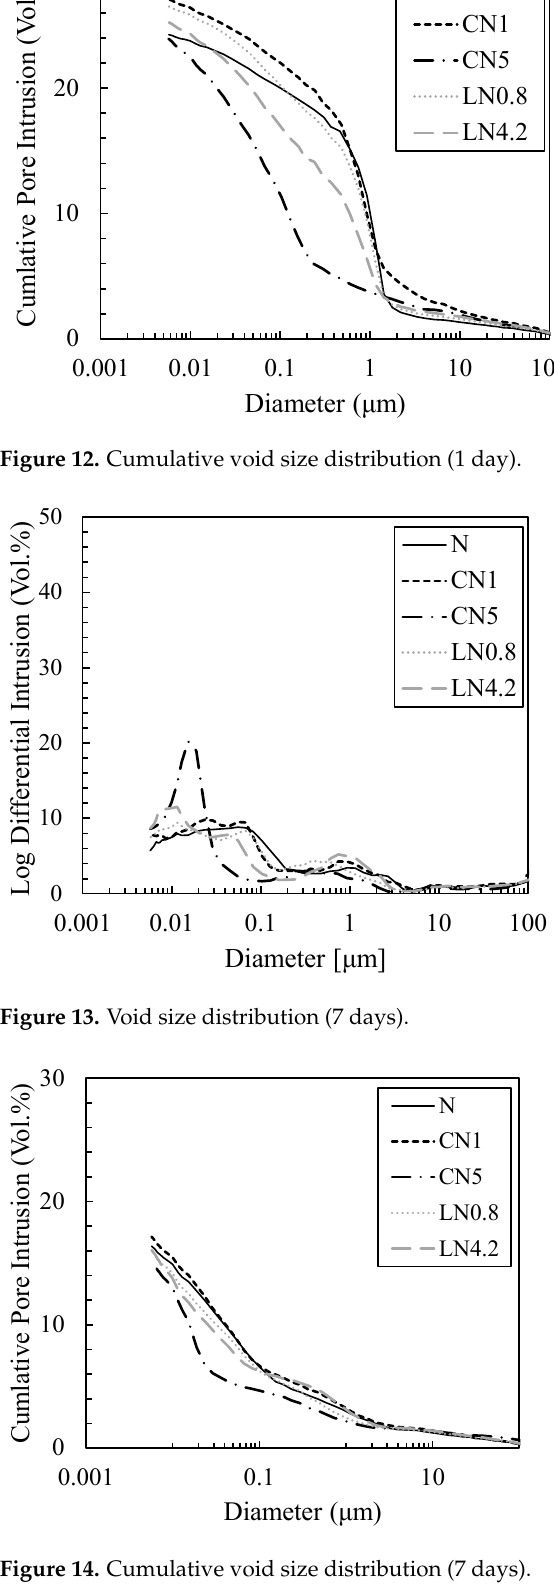
Figure 14. Cumulative void size distribution (7 days).